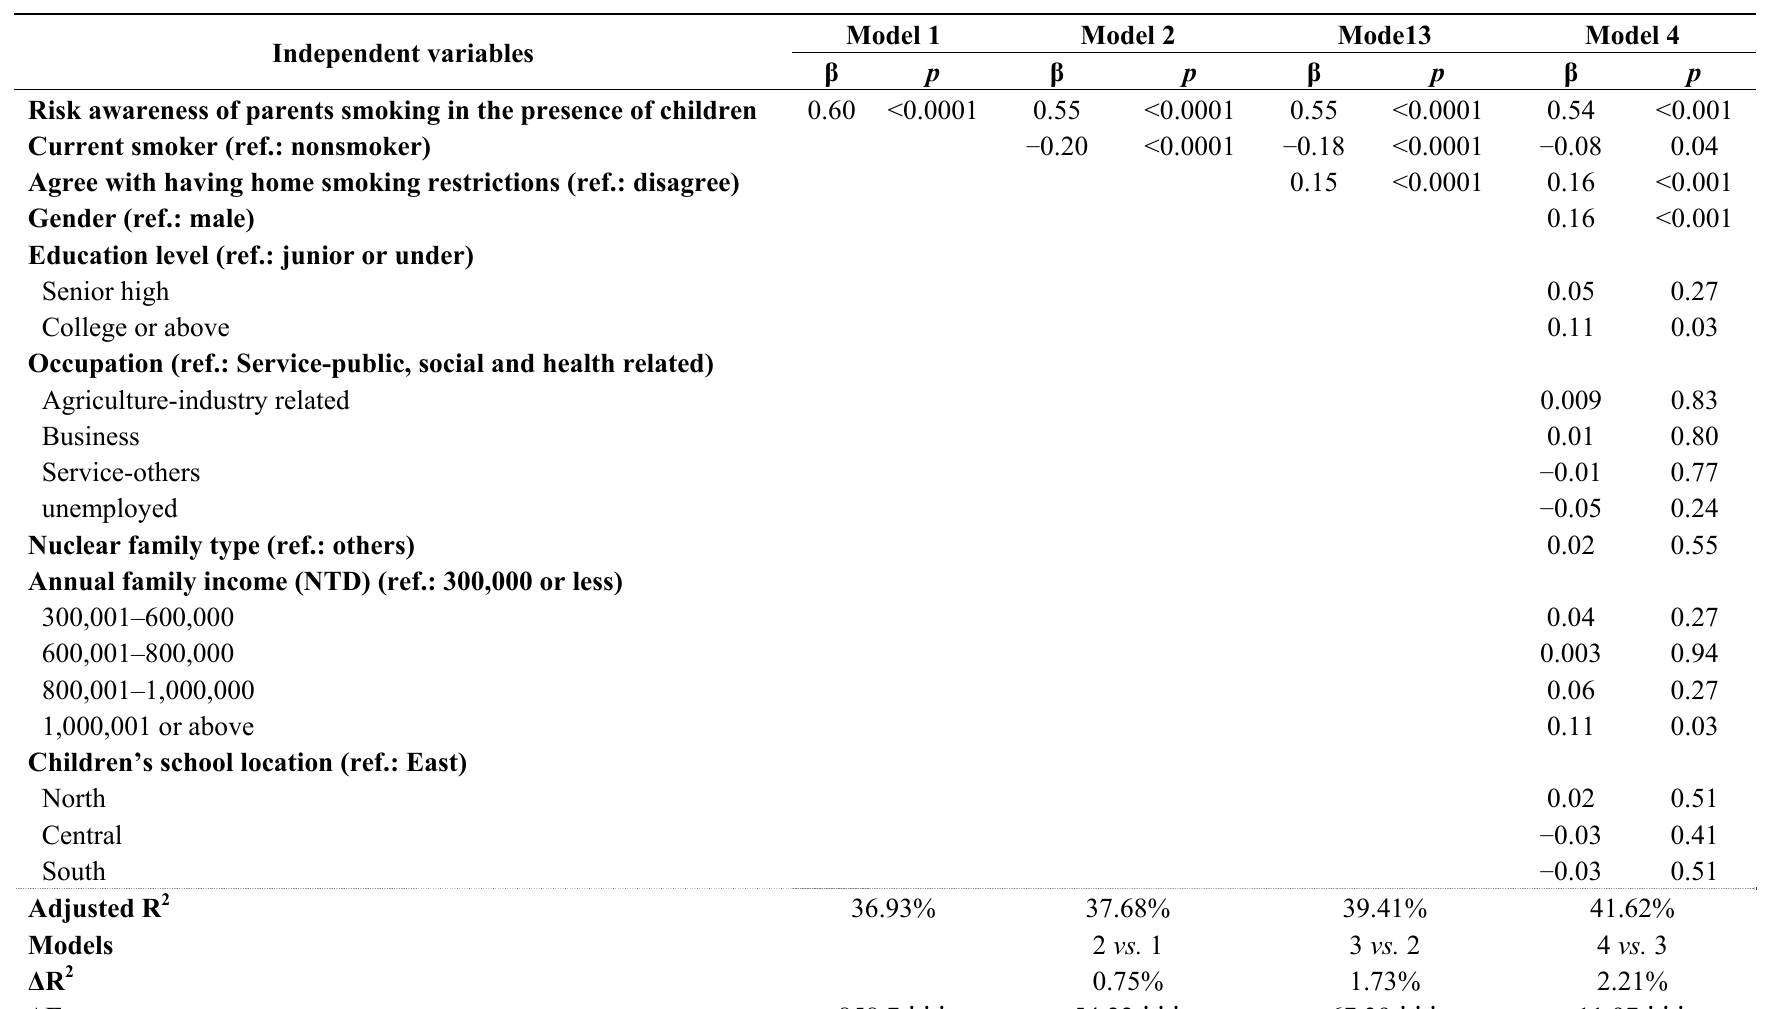
Table 4. Hierarchical Regression Analysis for factors predicting parental perceptions of parents smoking in the presence of